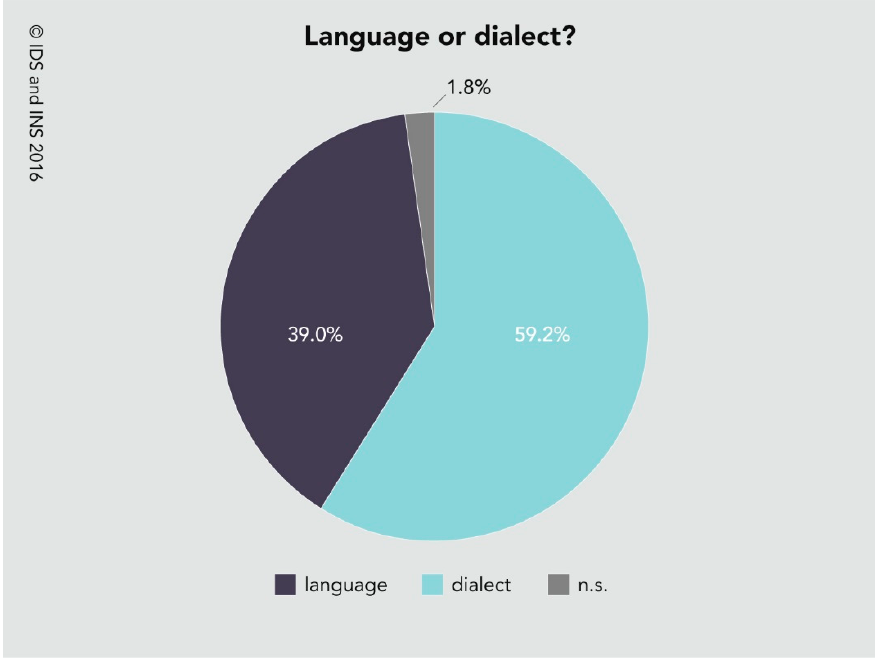
Figure 2. The assessment of Low German’s status: Language or dialect (n.s. = not specified; NGS2016; Adler et al. 2018, p. 29).